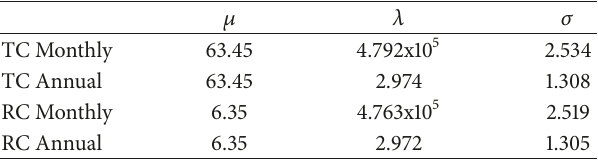
Table 7: OUP parameters obtained in the calibration